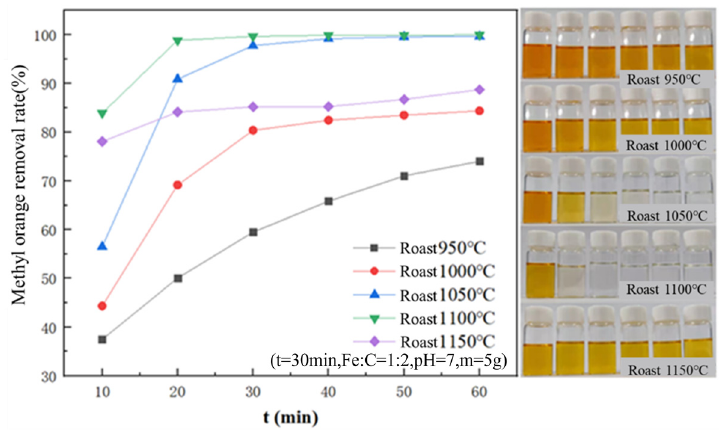
Figure 11. The e ff ect of sintering temperature on the removal of the fi ller methyl orange. Figure 11. The effect of sintering temperature on the removal of the filler methyl orange.